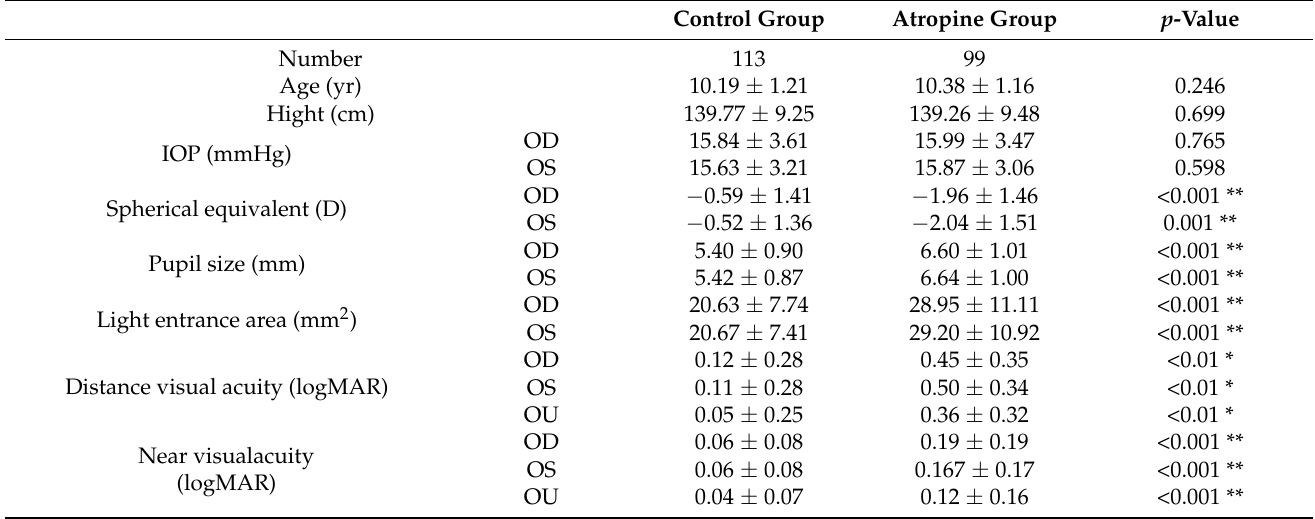
Table 1. Comparison of characteristics between the atropine group and the control group. Control Group Atropine Group p